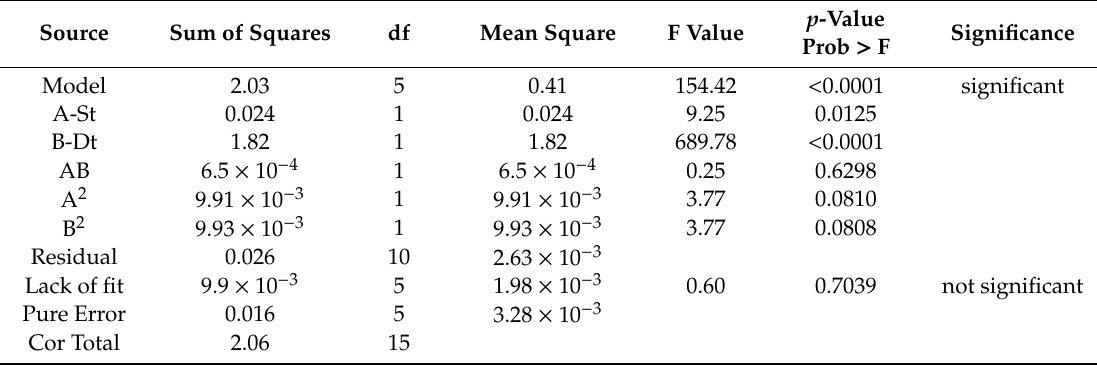
Table 4. ANOVA for nitrogen absorption.